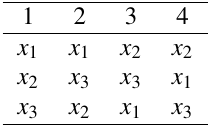
Table 2. Voters’ profile